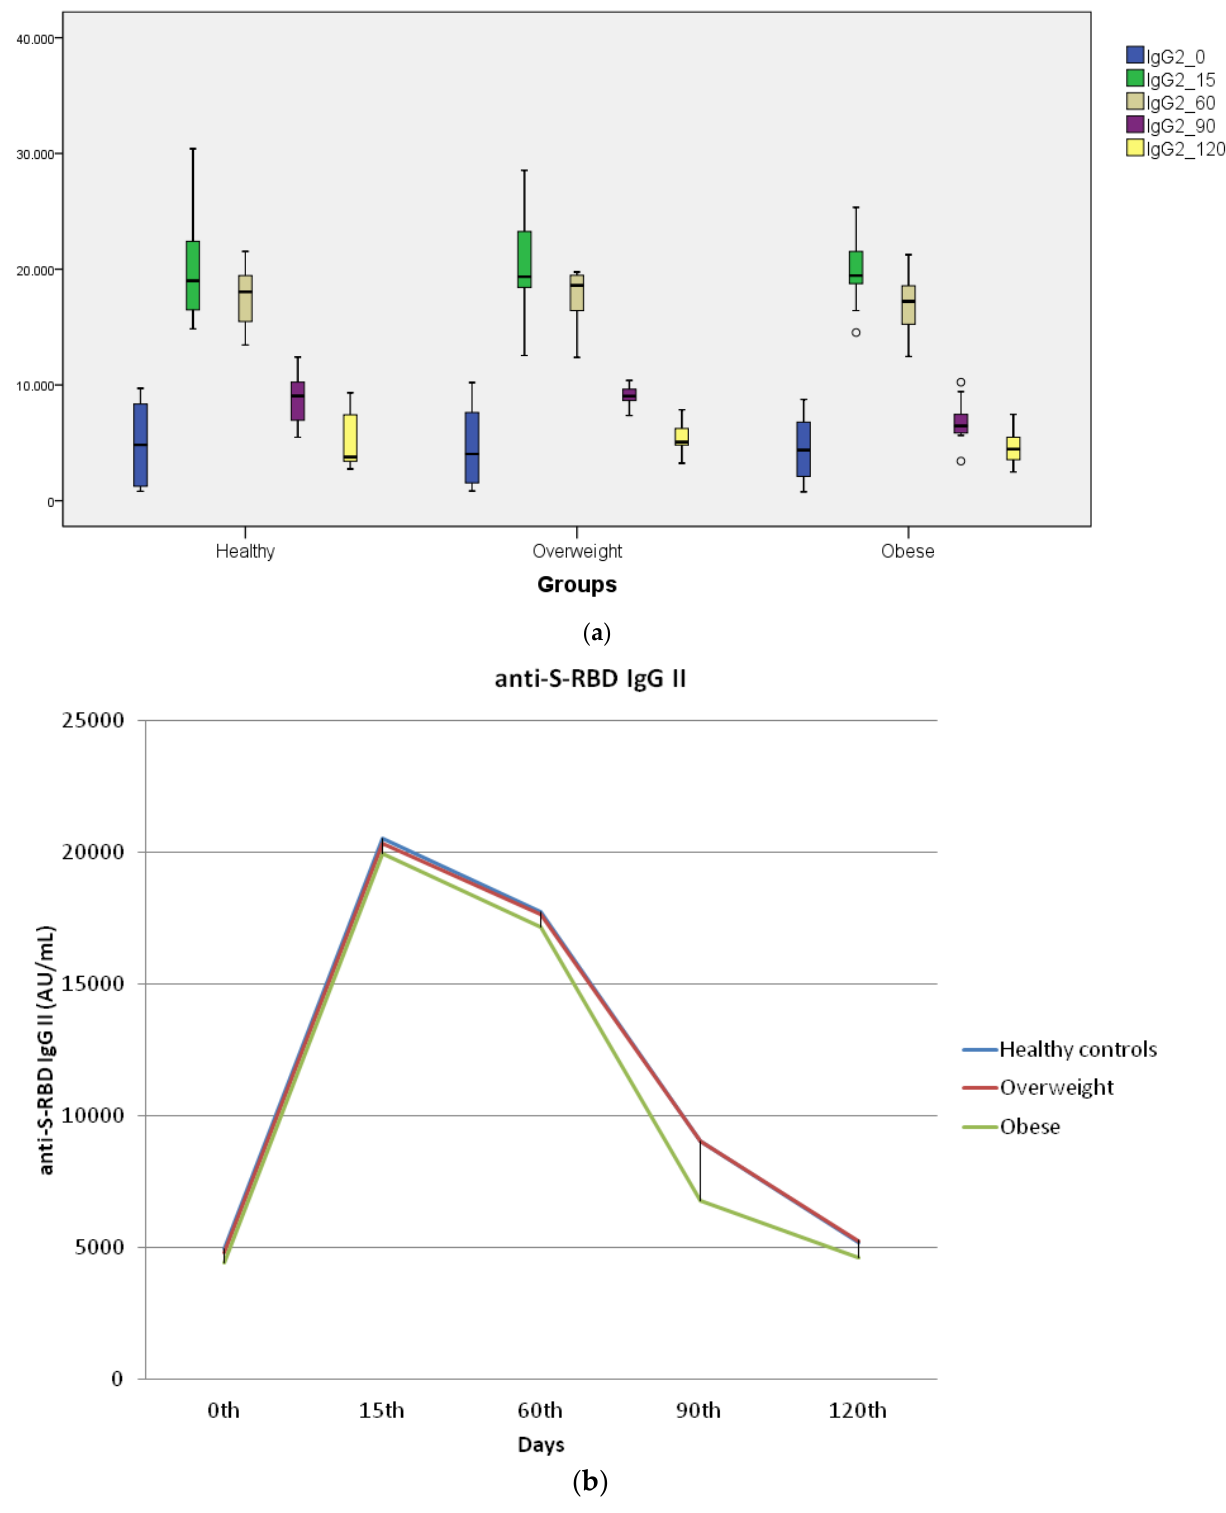
Figure 1. ( a ) Distribution of anti-S-RBD IgG antibody titers (AU/mL) before and after the third dose of BNT162b2 vaccine (on the 15th, 60th, 90th, and 120th days) for all groups (box plots). ( b ) Distribution of anti-S-RBD IgG antibody titers (AU/mL) before and after the third dose of BNT162b2 vaccine (on the 15th, 60th, 90th, and 120th days) for all groups (line plots).